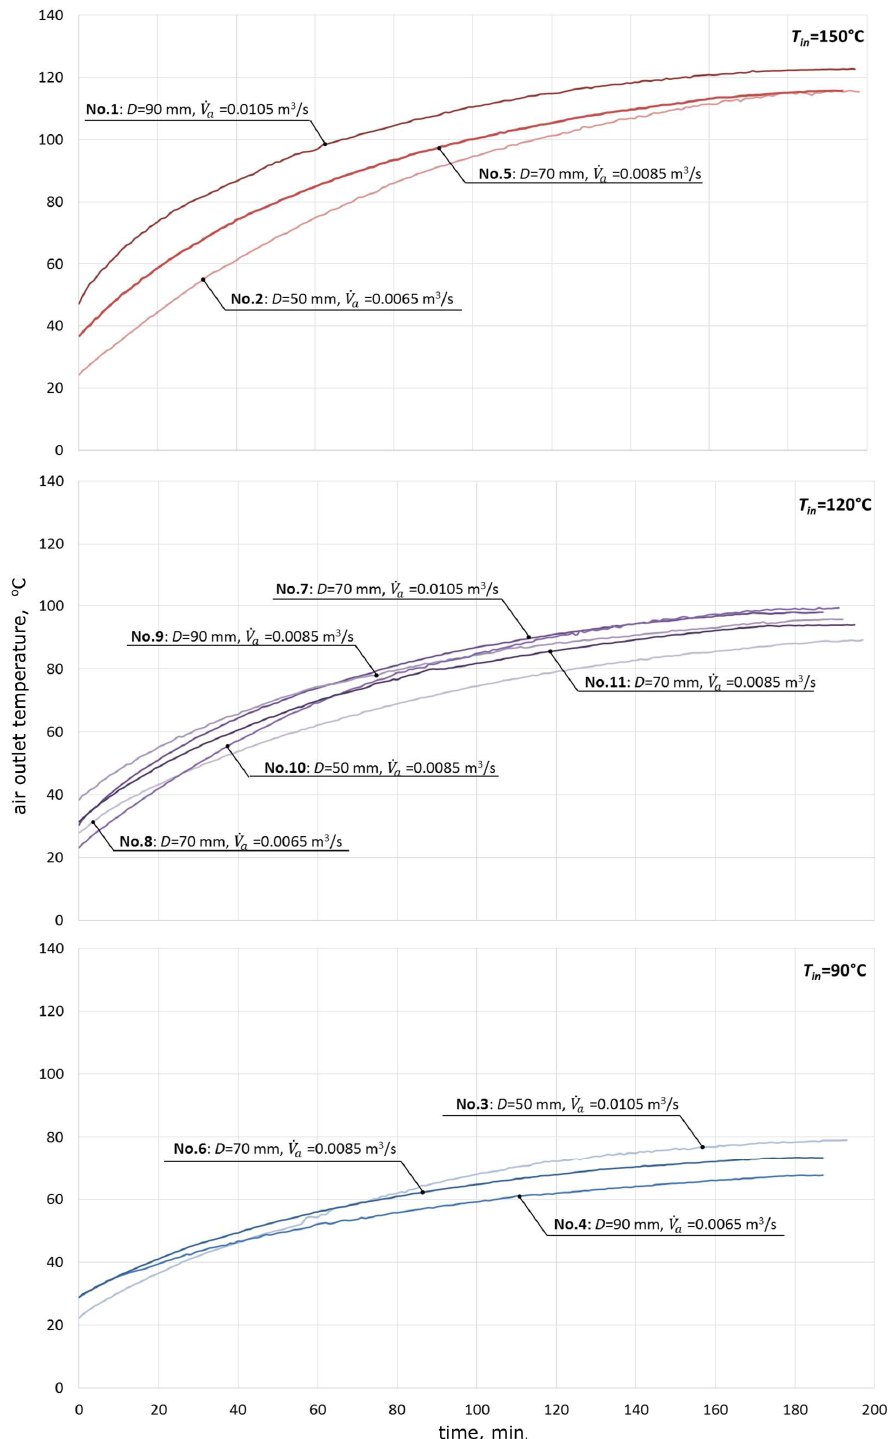
Figure 7. The relationship between the air temperature at the outlet of the packed bed and the time for 11 measurement series.